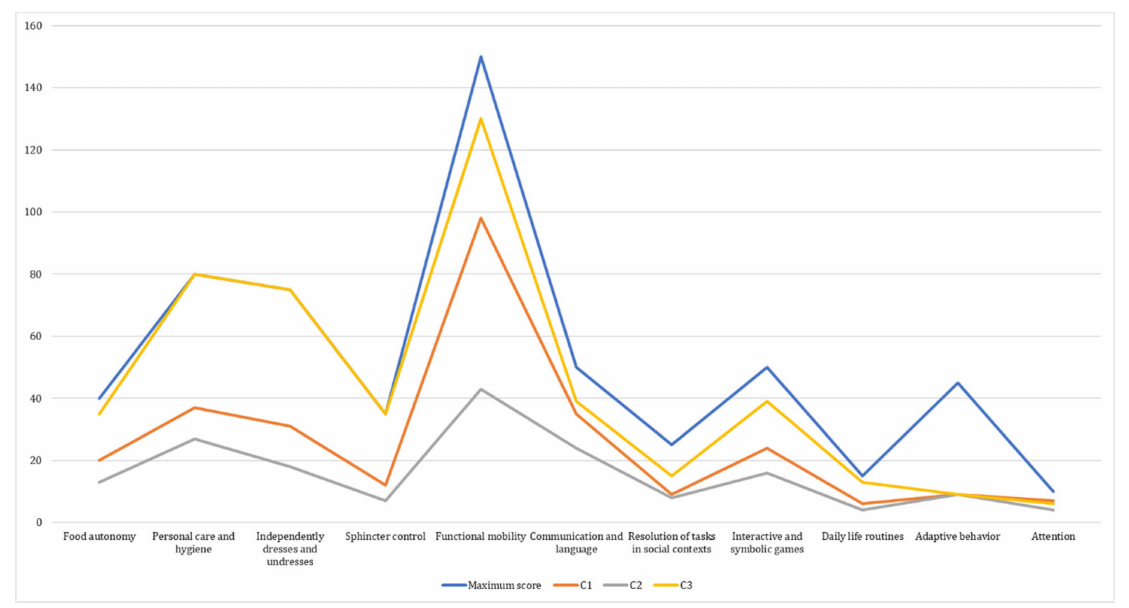
Figure 10. Comparison of scores in the 11 functional areas by cluster, and maximum scores for each area.